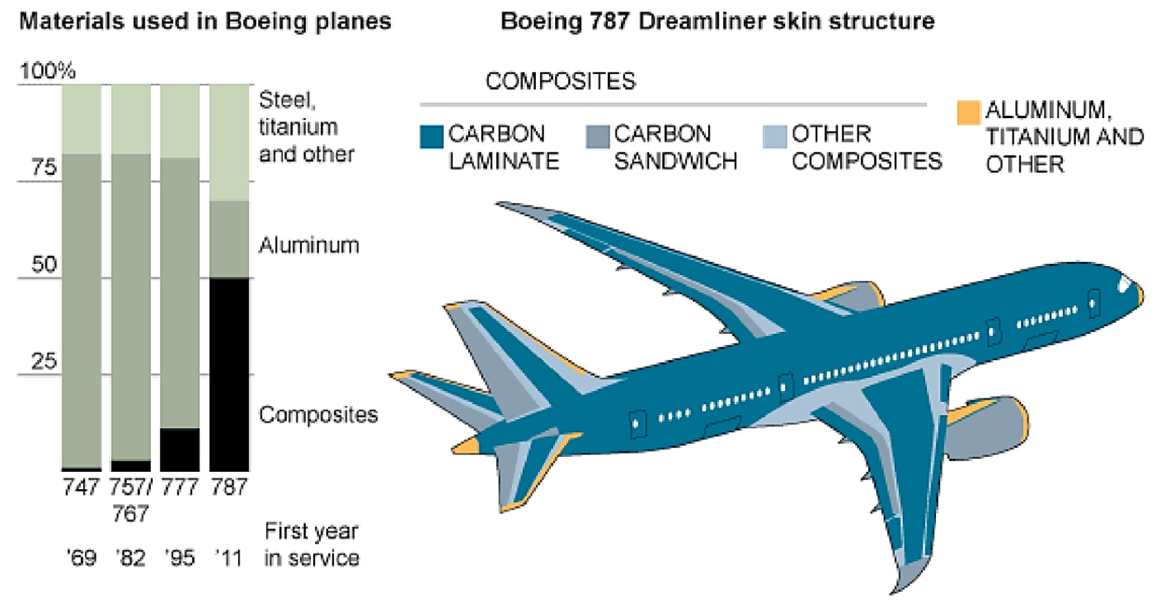
Figure 1. Various composite parts of a Boeing 787 [18].